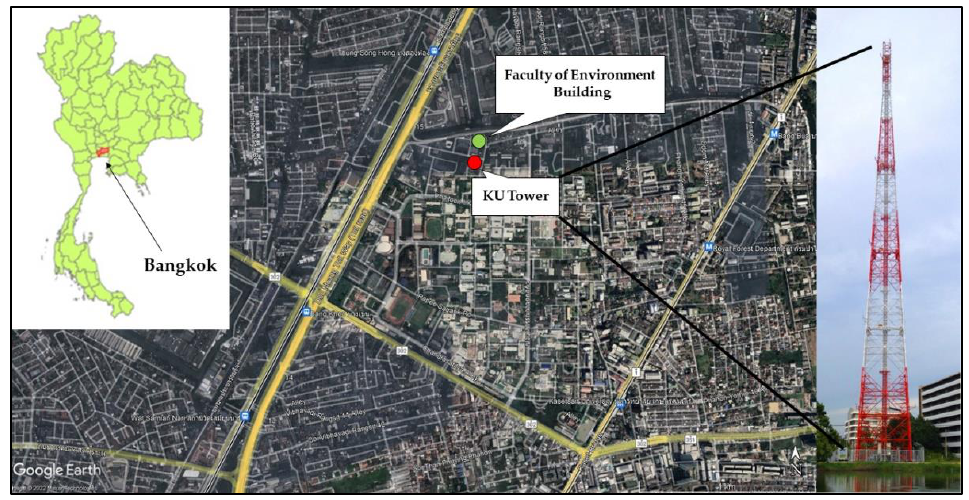
Figure 1. Location of data acquisition instruments at Kasetsart University, Bangkok, Thailand.